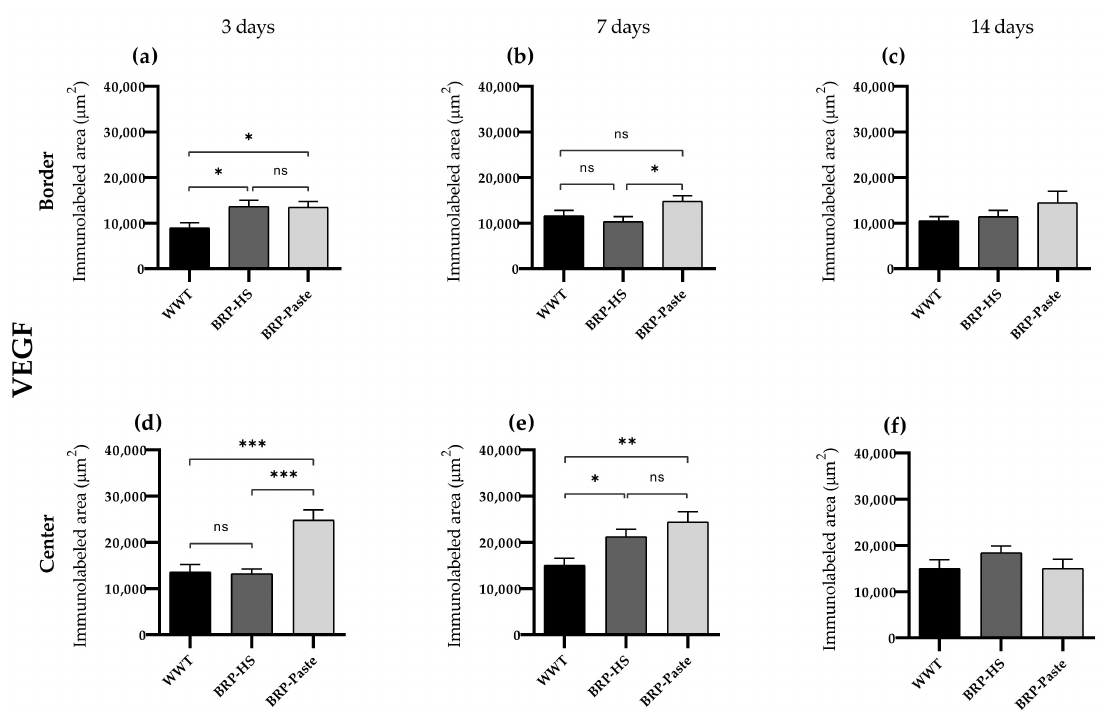
Figure 10. Quantification of VEGF by area ( µ m 2 ) at border ( a – c ) and central ( d – f ) regions (dermis) of the wounds in each experimental group for the periods of 3 ( a , d ), 7 ( b , e ) and 14 ( c , f ) days of treatment. The statistical difference compared to the WWT group was obtained by one-way ANOVA followed by a Newman-Keuls test in which * p < 0.05, ** p < 0.01, and *** p < 0.001 ( n = 6). ns = no